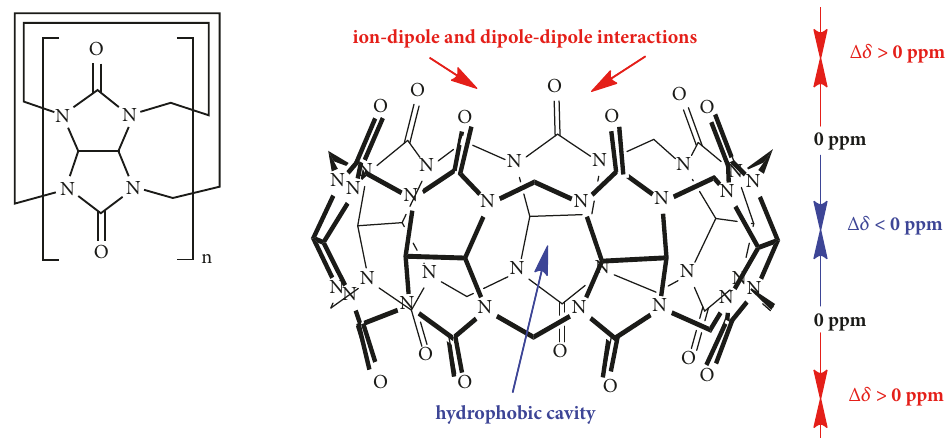
Figure 1: Structures of CB[n] (left) and CB [7] (right), indicating regions of CB [7] complexation-induced chemical shift changes ( (cid:2) 𝛿 ) for the guest proton